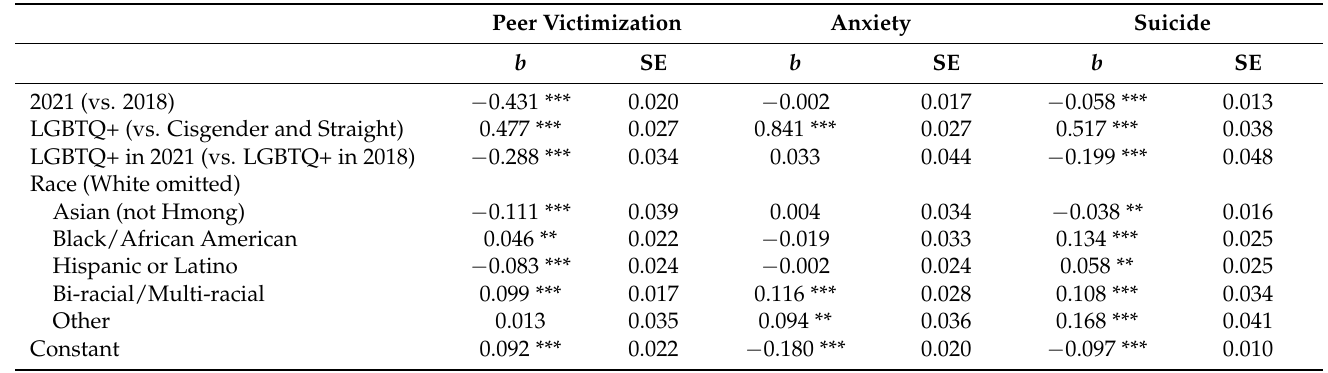
Table 4. Multivariate OLS regression analysis examining whether sexual orientation/gender identity moderates the relationships between pre-/during-pandemic peer victimization, anxiety, and suicide